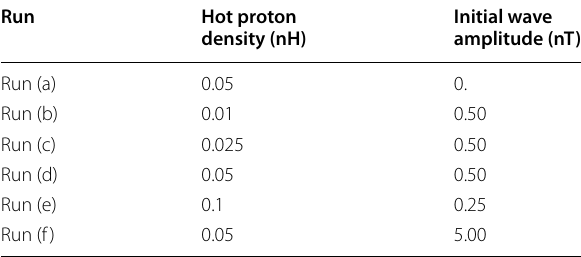
Table 1 Initial parameters for hot plasma density